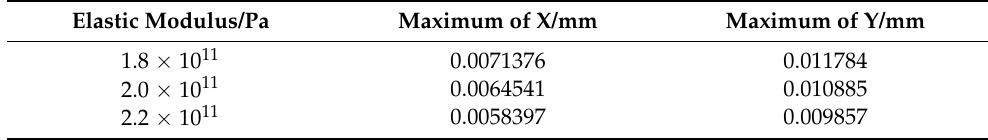
Figure 18. Maximum X (transverse) and Y (vertical) of elastic modulus of 1.8 × 10 11 Pa. And the maximum of X and Y is shown in Table 4. Table 4. Maximum of X (transverse) and Y about elastic modulus. Elastic